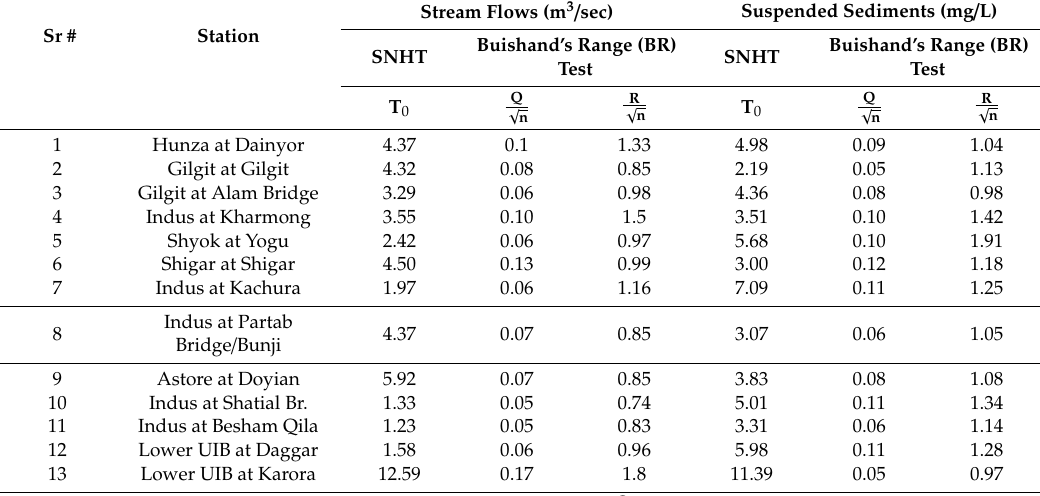
Table 4. Characteristics of climatic gauging stations in the Upper Indus Basin